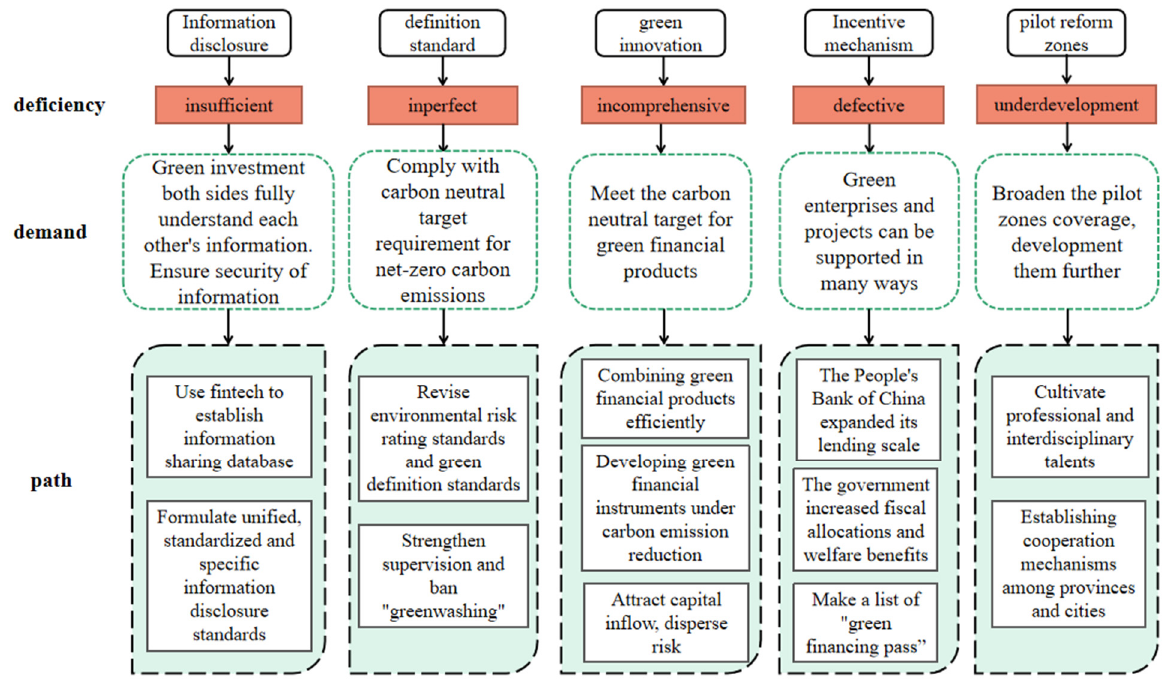
Figure 5. Deficiency demands and paths of green finance to help achieve carbon neutrality.